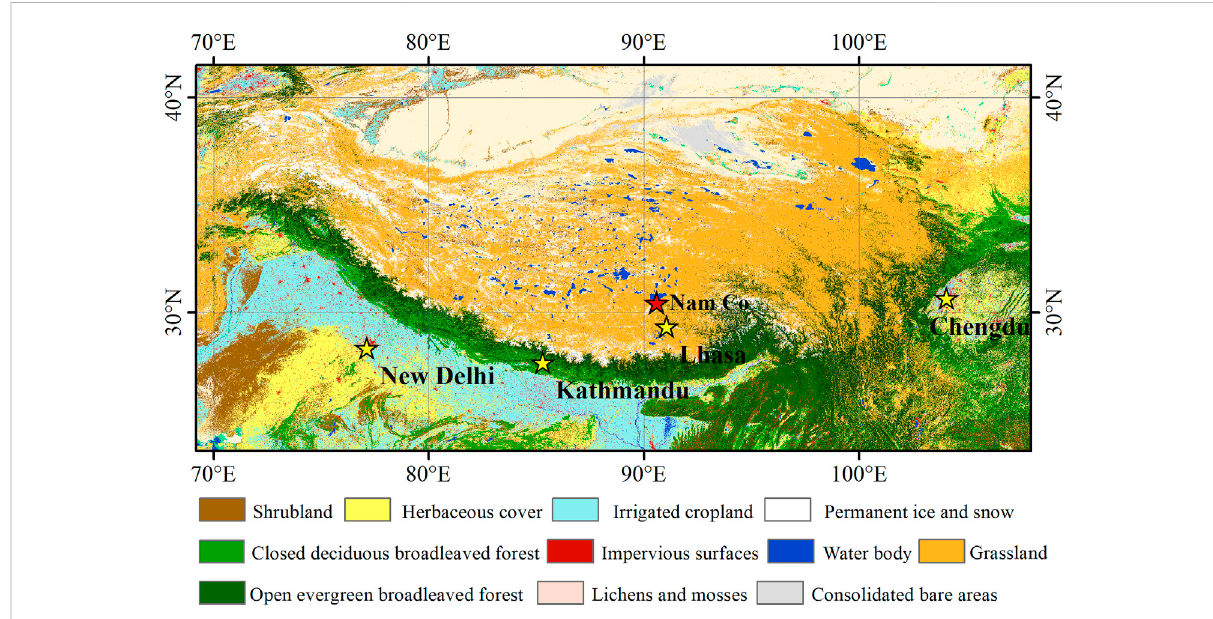
Nam Co Station (red), land cover data from the Global Land Cover with Fine Classi fi cation System at 30 m in 2020 (GLC_FCS30-2020) of the Institute of Spatial Information Innovation (Zhang et al., 2021b), Chinese Academy of